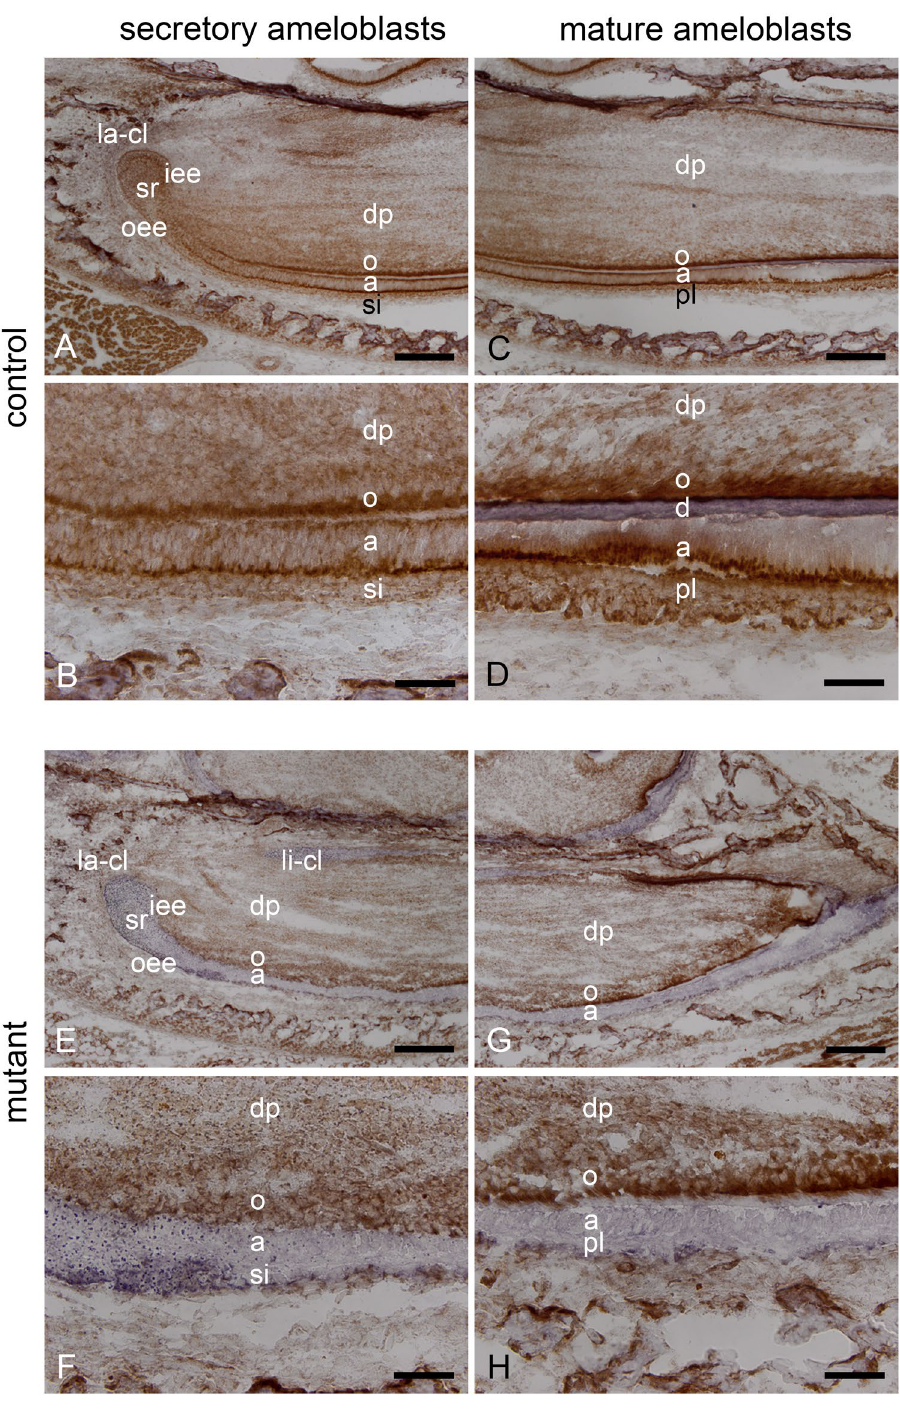
Figure 1. Histochemical localization of COX/SHD-staining in cells of the developing incisor of control and mutant K320E-Twinkle Epi mice at P3. In P3 control mice COX/SHD is detected in stem cells of the cervical loop, in cells of the enamel epithelium and in odontoblasts ( A – D ). In P3 K320E-Twinkle Epi mice COX/SHD staining is localized in cells of the dental papilla and in odontoblasts ( E – H ). However, no brown COX staining is found in the cervical loop or in the layers of the enamel epithelium ( E – H ). a, ameloblasts; dp, dental papilla; iee,